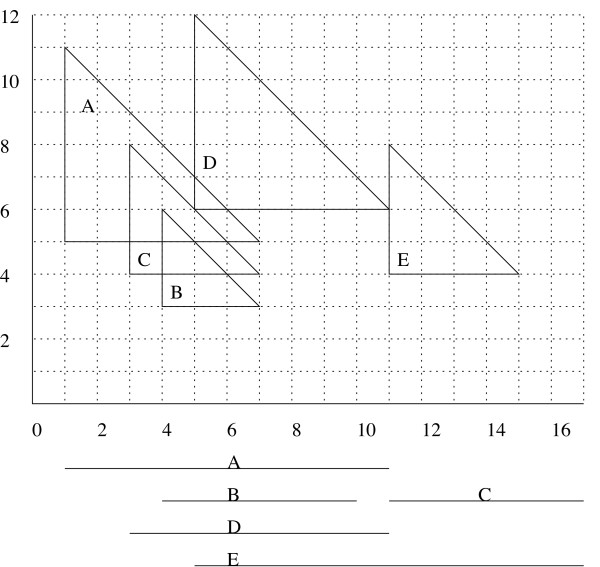
A set of intervals A-E together with its corresponding semi-square representation. This example for c = 0.5 also shows that not all candidate cliques are maximal with respect to the set of active semi-squares: When D is born, there are two maximal cliques in the y-structure: {A, B} and {B, C}. D is intersecting with A and B. Thus, there will be one candidate clique {A, B, D}, built from clique {A, B}, and {A, D}, built from {B, C}. The latter candidate clique is thus not maximal with respect to all active cliques and should not be inserted into Q.